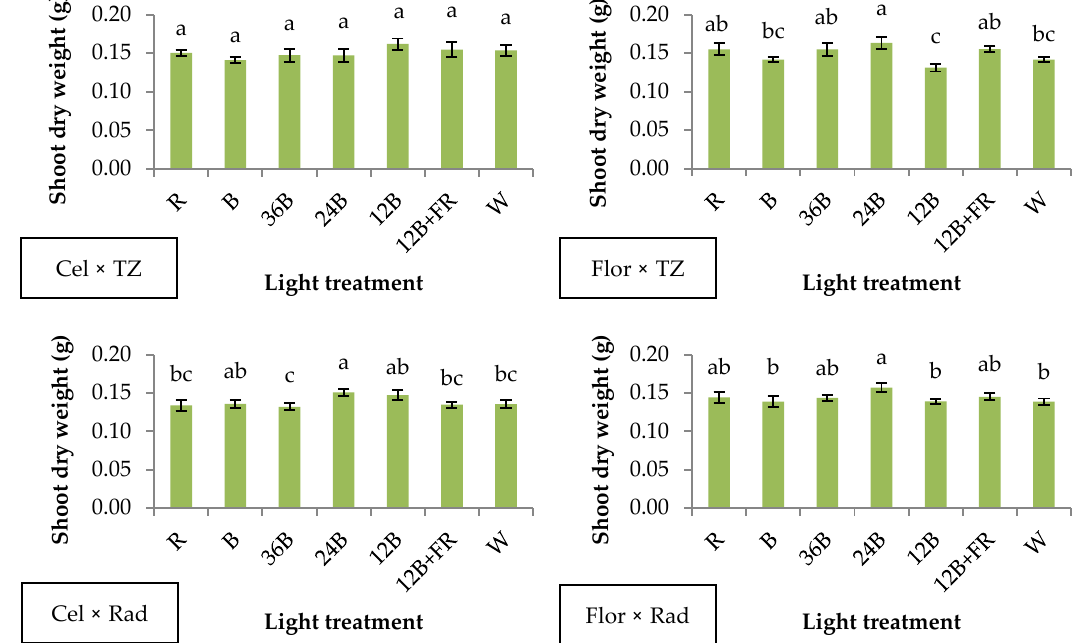
Figure 3. Shoot dry weight of grafted watermelon seedlings derived from four watermelon × interspecific squash genotype combinations, and after illumination by seven light treatments during healing. Bars ( ± SE) followed by different letters are significantly different ( p ≤ 0.05).